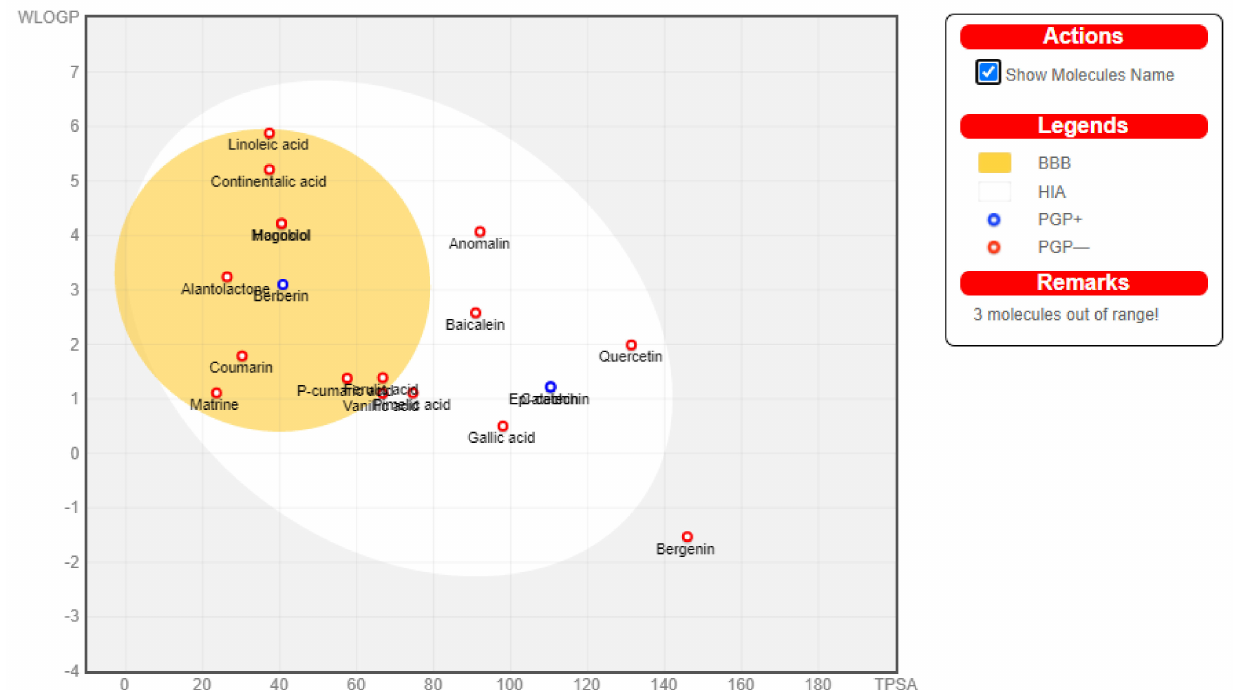
Figure 3. The boiled egg analysis was performed to assess the blood–brain barrier and human intestinal absorption of the studied compounds. The compounds that can penetrate the blood–brain barrier lie within the yellow color, while those lying within the yellow color indicate not permeable to the brain.